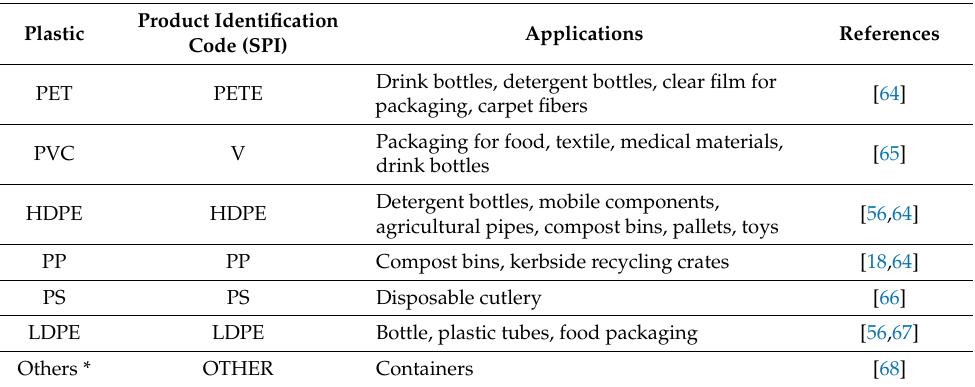
Table 3. Applications of recycled